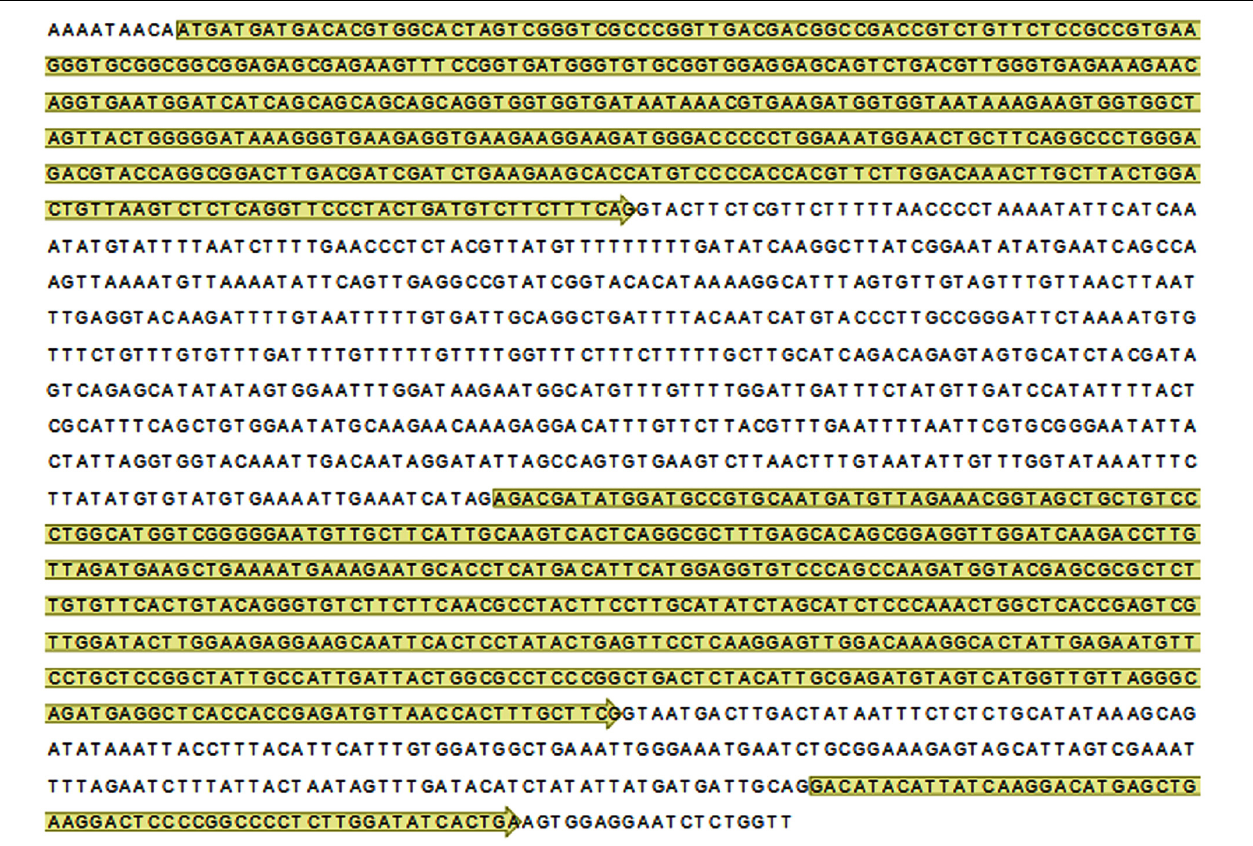
FIGURE 6 | Nucleotide sequence of gDNA encoding Daucus carota L. cv. Rotin AOX1 ( DcAOX1) (GenBank acc. n o . KJ669723). Exons are indicated in yellow.